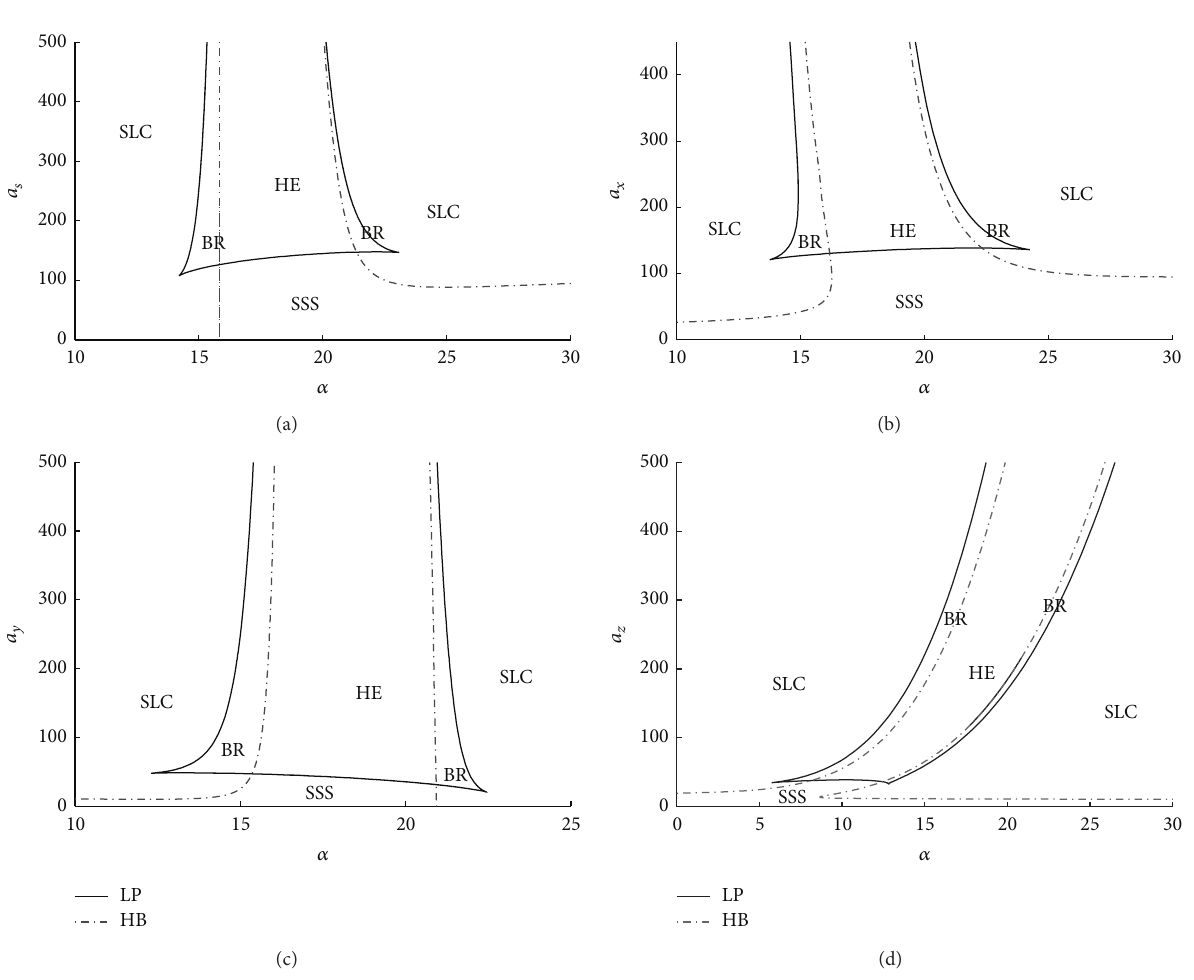
Figure 4: Bifurcation diagrams of two parameters showing the domains of different dynamical behaviors for model (1). (a) 𝛼 and 𝑎 𝑠 , (b) 𝛼 and 𝛼 and 𝑎 𝛼 and 𝑎 𝑎 𝑥 , (c) 𝑦 , and (d) 𝑧 . Notations are SLC for single stable limit cycle, SSS for stable steady state, BR for birhythmicity, and HE for hard excitation. Black solid lines stand for limit point bifurcation (LP); dot-dashed lines denote Hopf bifurcation (HB). All these notations represent the same meaning in the following bifurcation diagrams about two parameters throughout the whole paper. The diagrams have been established by numerical integration of (1) with the parameter values listed in Section